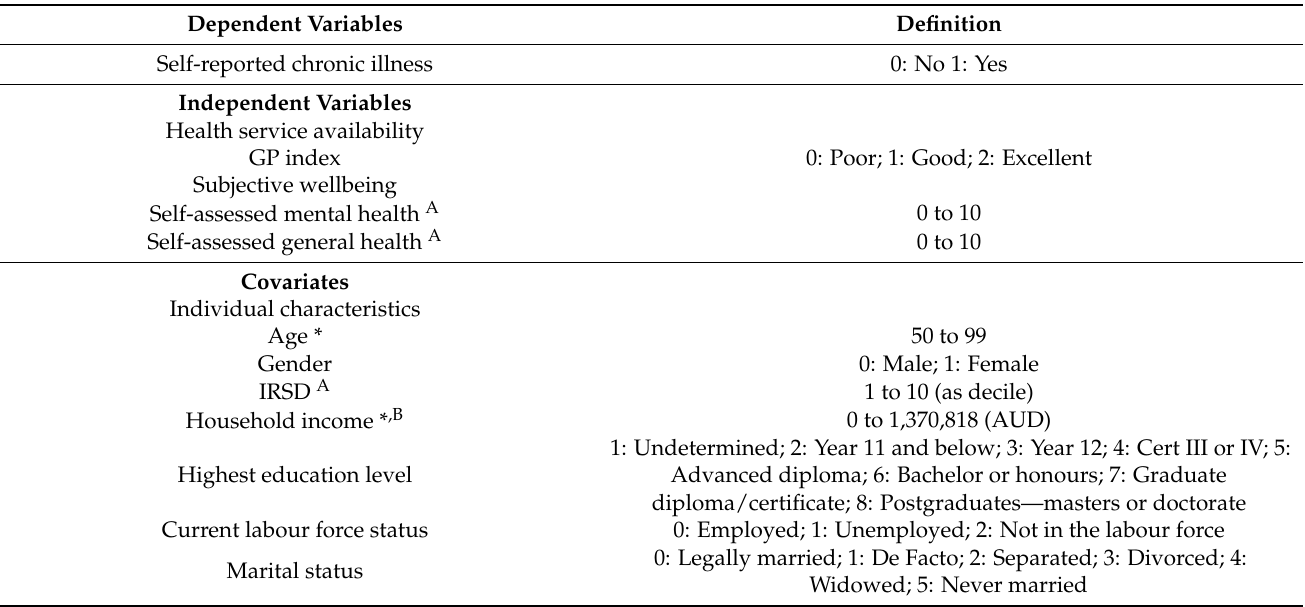
Table 1. Variables and covariates used in the binomial logistic regression